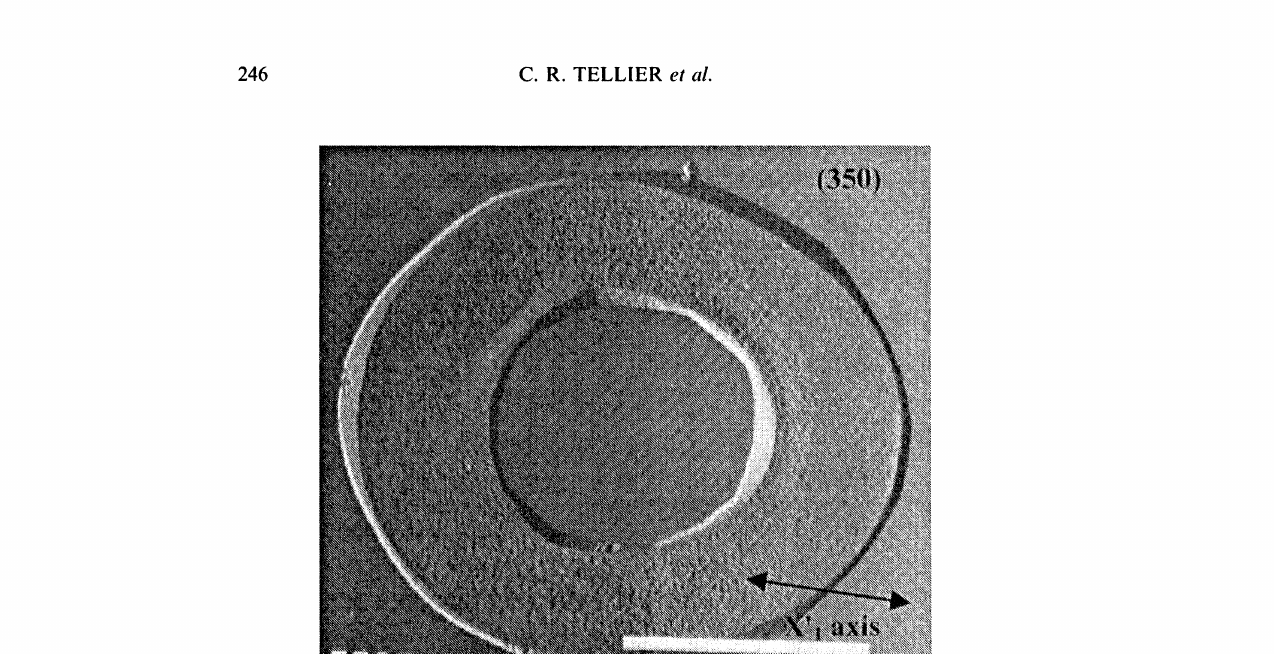
FIGURE 3 SEM image of the "circular" (3 50) membrane-mesa